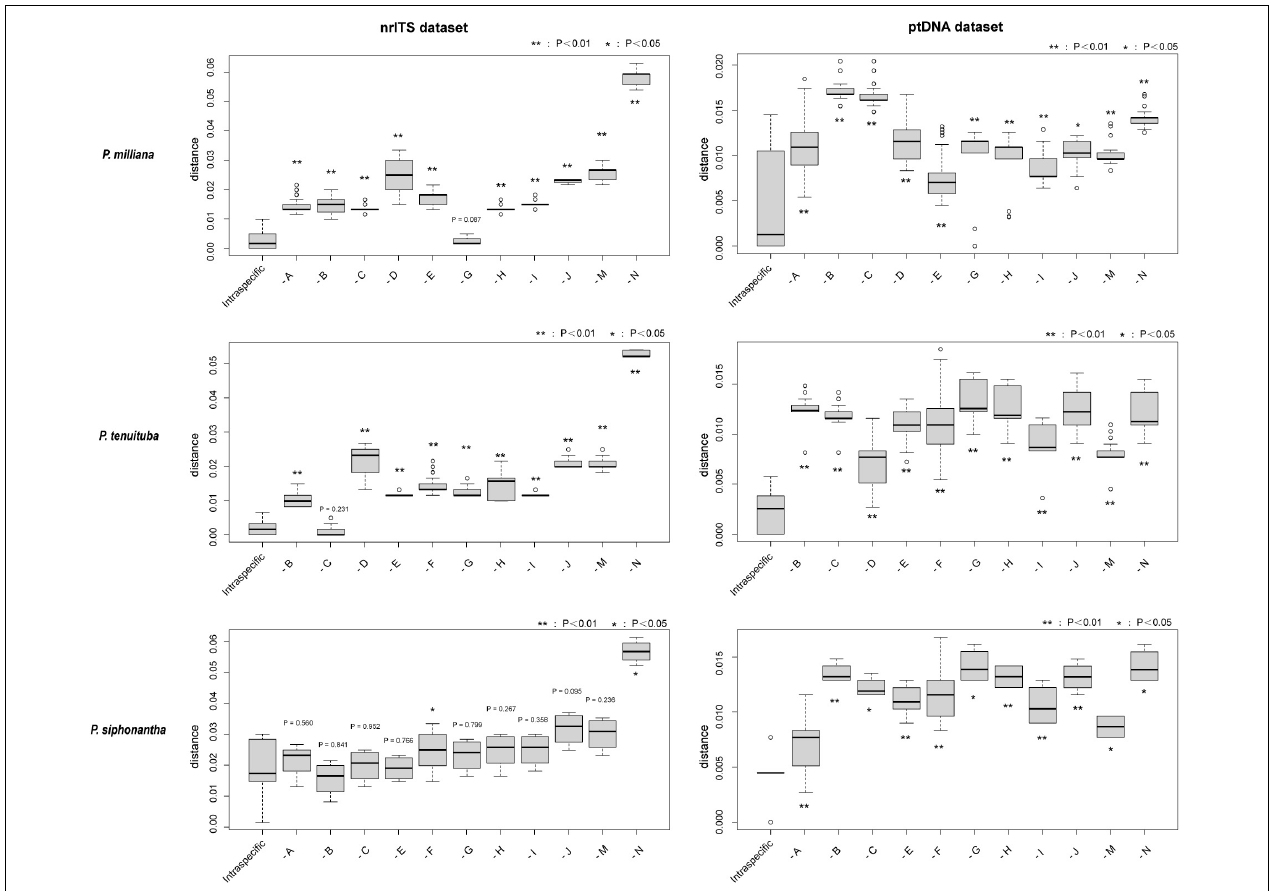
FIGURE 3 | K-S test for intraspecific and interspecific genetic distance. The intraspecific genetic distance of Pedicularis milliana , Pedicularis tenuituba , and Pedicularis siphonantha are estimated. Statistical significance was shown on every group (** P < 0.01, * P < 0.05). -A: to Pedicularis tenuituba ; -B: to Pedicularis leptosiphon ; -C: to Pedicularis dolichosiphon ; -D: to Pedicularis siphonantha ; -E: to Pedicularis sp. 2 from Jiaozi Snow Mountain; -F: to Pedicularis milliana ; -G: to Pedicularis sp. 1 from Ganheba; -H: to Pedicularis sigmoidea ; -I: to Pedicularis variegata ; -J: to Pedicularis dolichantha ; -M: to Pedicularis amplituba (outgroup); -N: to Pedicularis tahaiensis